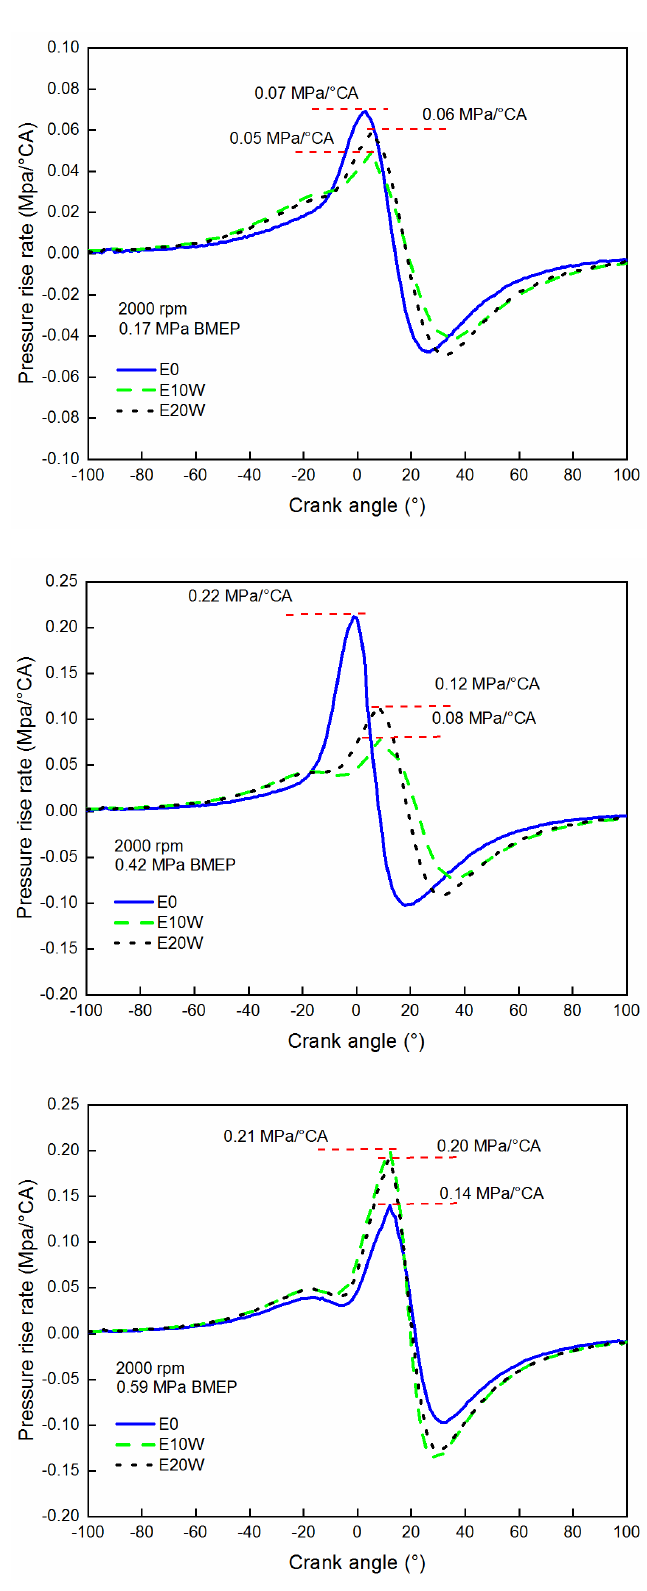
Figure 5. The average pressure rise rate of E0, E10W and E20W for three various loads.